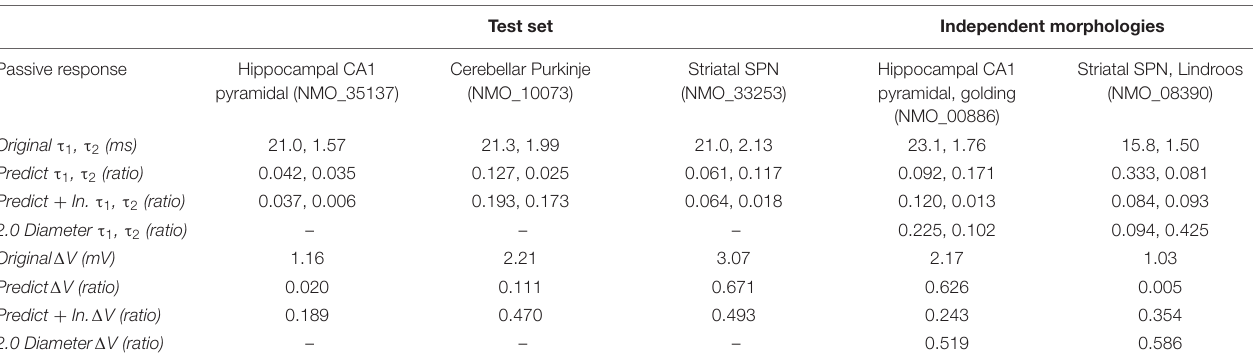
TABLE 5 | Passive response for select archive morphologies in test